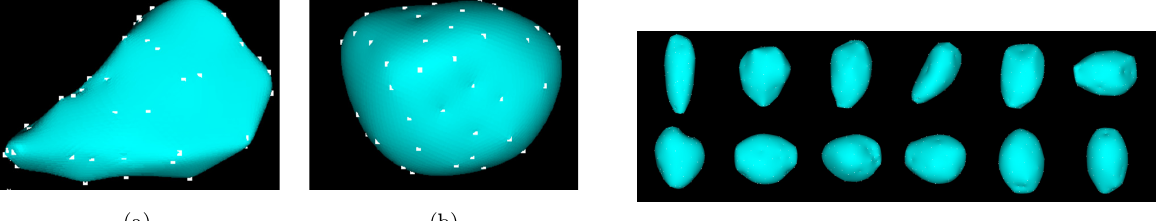
Fig. 6. Contour reconstruction result of three-dimensional spiral CT damage image.